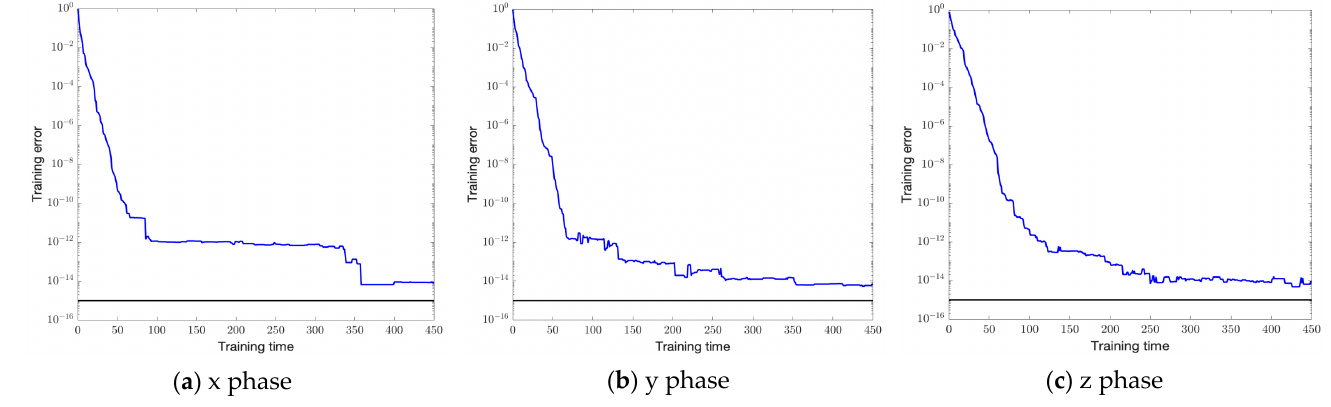
Figure 8. Three-dimensional Lorenz error iterative convergence curve. The blue line is the error iteration convergence curve, and the black line is the iteration termination condition set at 10 − 15